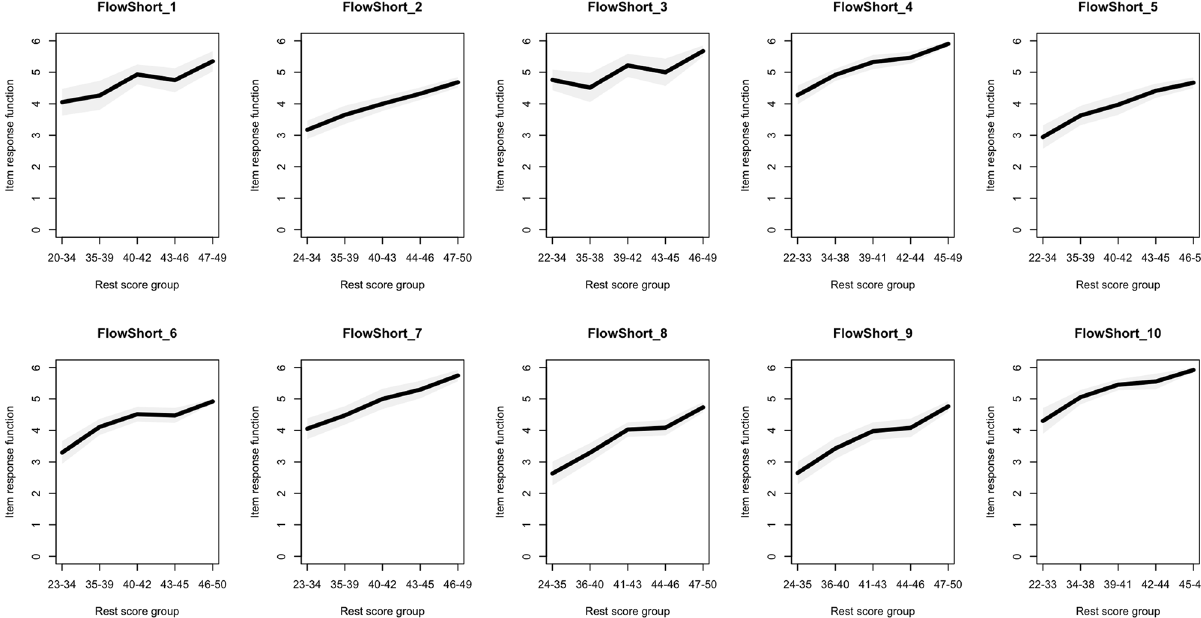
Figure 1. Monotonicity analysis of individual FSS items. The x-axis depicts the sum score of the whole scale. The y-axis depicts the item response function. Optimally, all item response functions should be relatively diagonal, or at the very least without downward dips. Items 1 and 3 have a clear zig-zag pattern, that is, a clear violation of